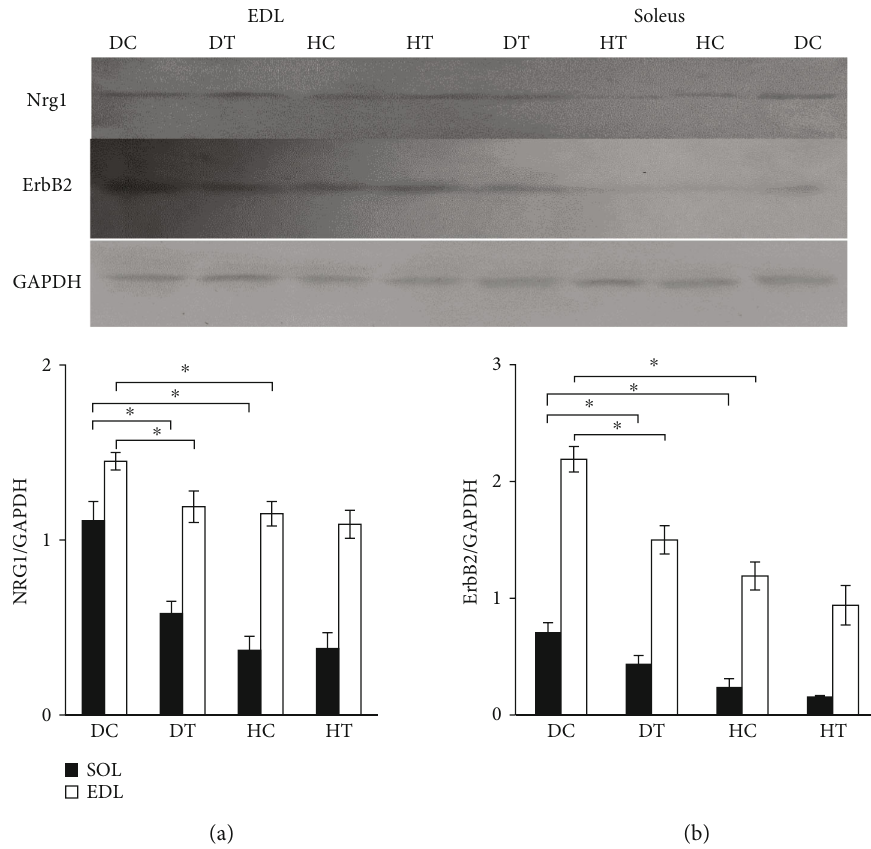
Figure 3: Expression of NRG1 (a) and ErbB2 (b) is demonstrated by Western blotting normalized to GAPDH. Panels above the graph are representative Western blot images from di ff erent groups. ∗ P < 0 : 05 vs. control rats (two-way ANOVA). DC: diabetic control rats; DT: diabetic and trained; HC: health and control; HT: health and trained. Sol: soleus; EDL: extensor digitorum longus. Five rats in each group were utilized for this analysis. The analysis was performed in